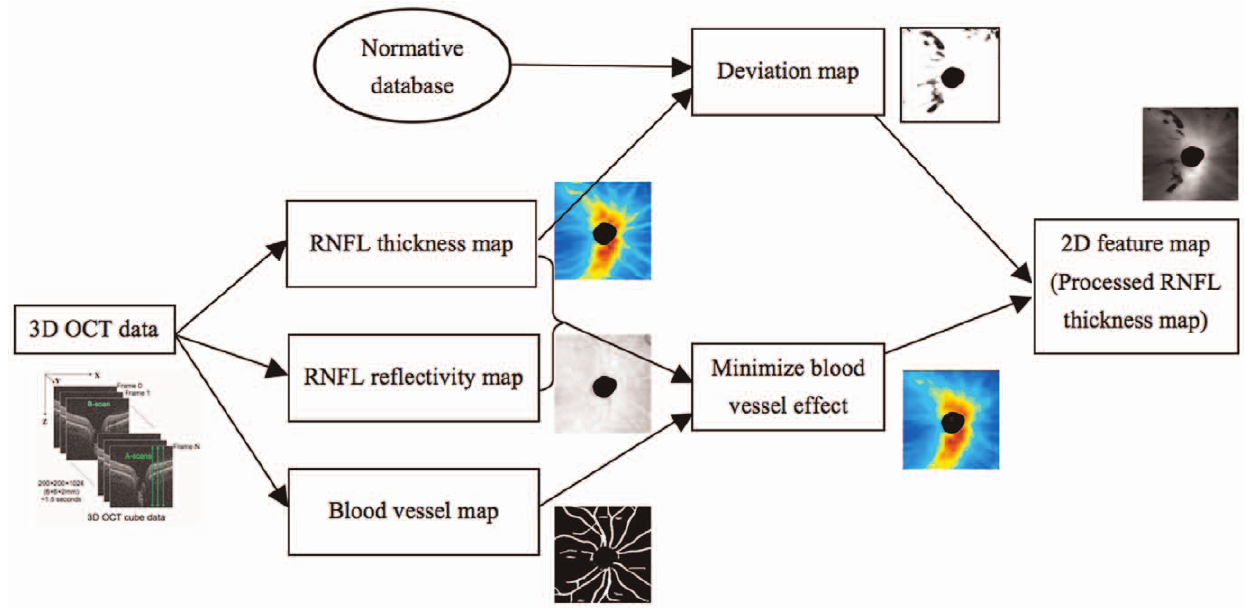
Figure 3. Flowchart of converting a 3D OCT image into a 2D feature map.